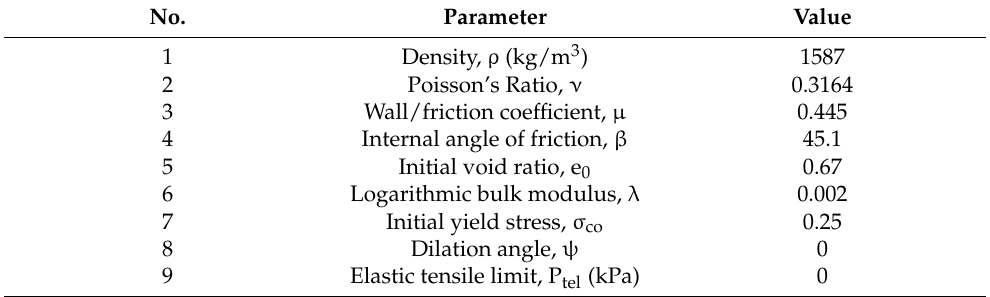
Table 1. Properties of bulk solids applied in the model.